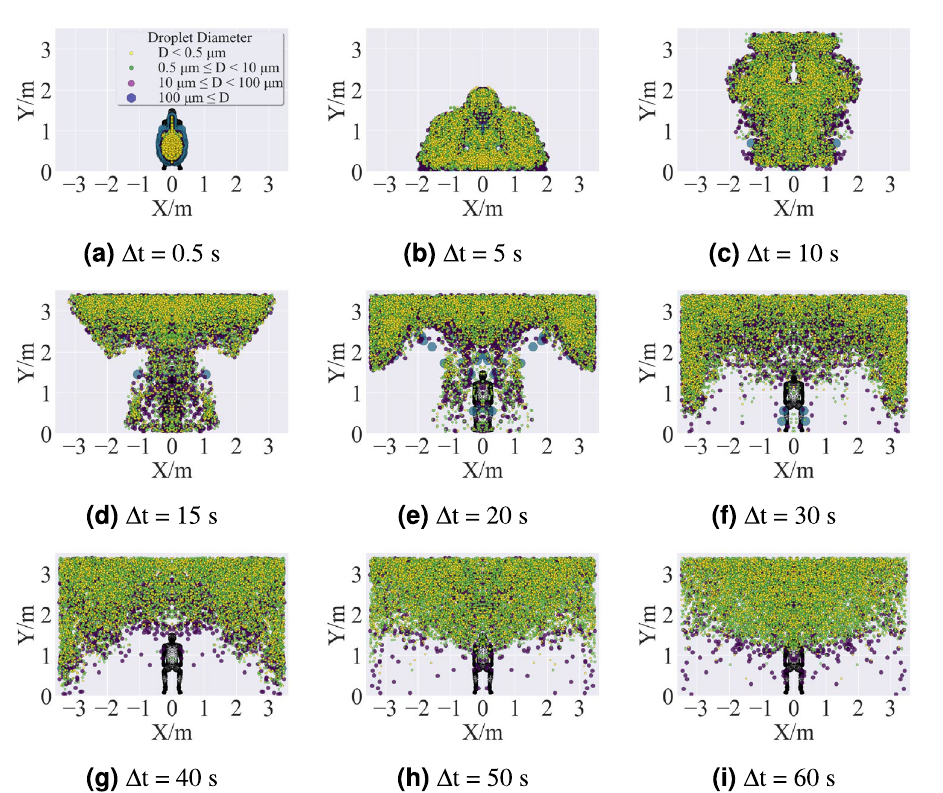
Figure 21. Front view of cumulative time distribution of droplet clouds in Case 1. The distributions of droplets were predicted by using the ANSYS Fluent (version 2019 R2) and drawn by Matplotlib (version